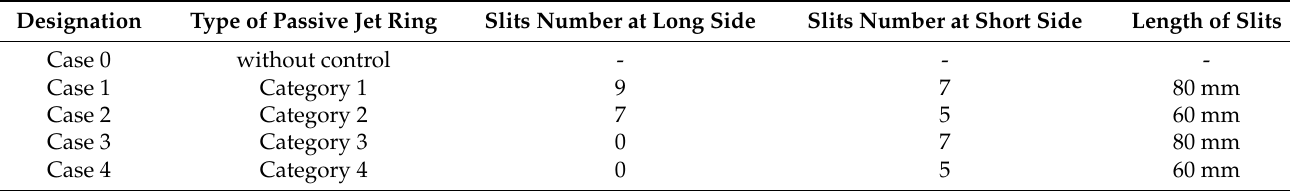
Table 1. Test conditions of the